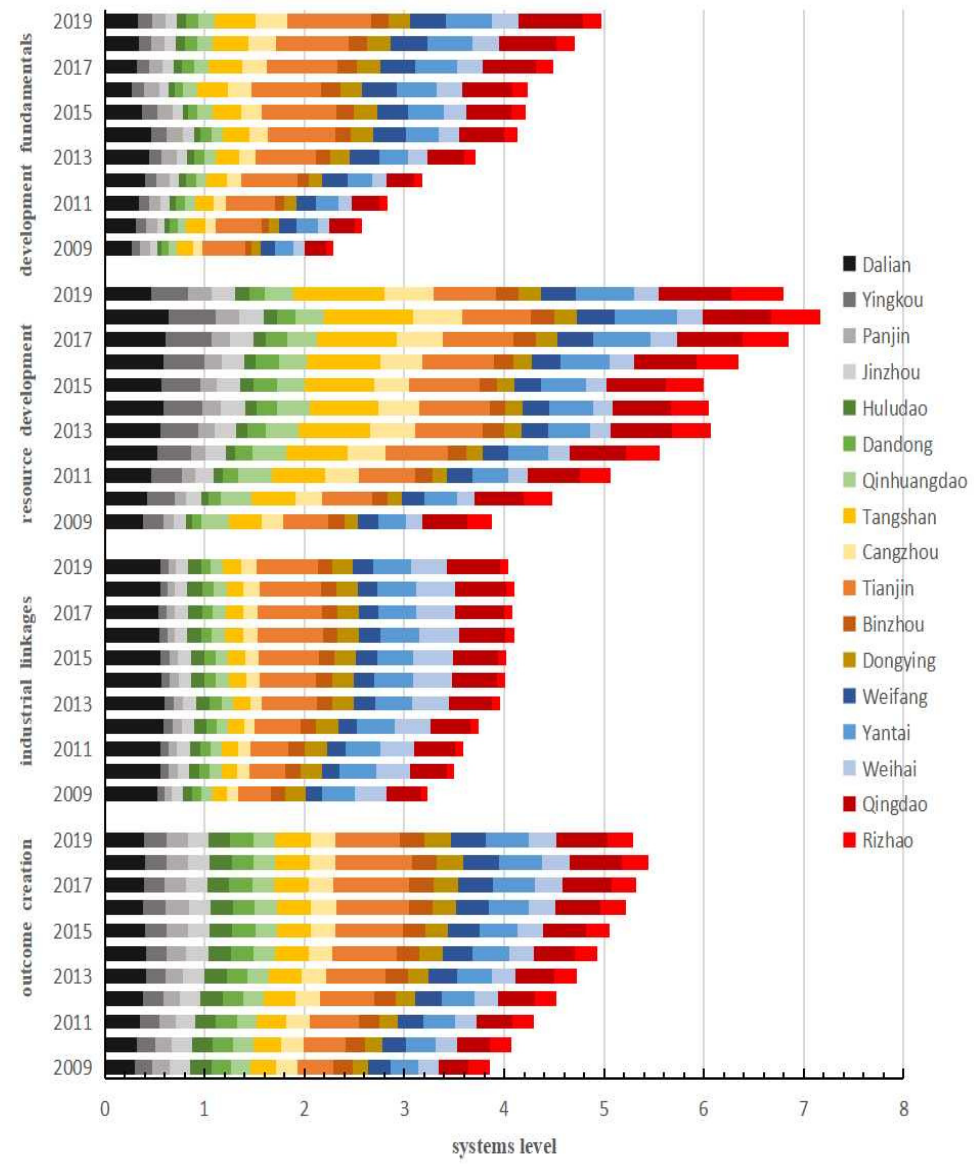
Figure 3. Proportion of Bohai Rim city system-level index (2009–2019). Source: own elaboration on the base of a system for assessing the development of a city’s capacity to integrate its marine and terrestrial ecological economies and formula (1), (2), (3), (4). Table 3. Global spatio-temporal Moran’s I of the integration capacity between the marine and terrestrial ecological economies. Source: own study.